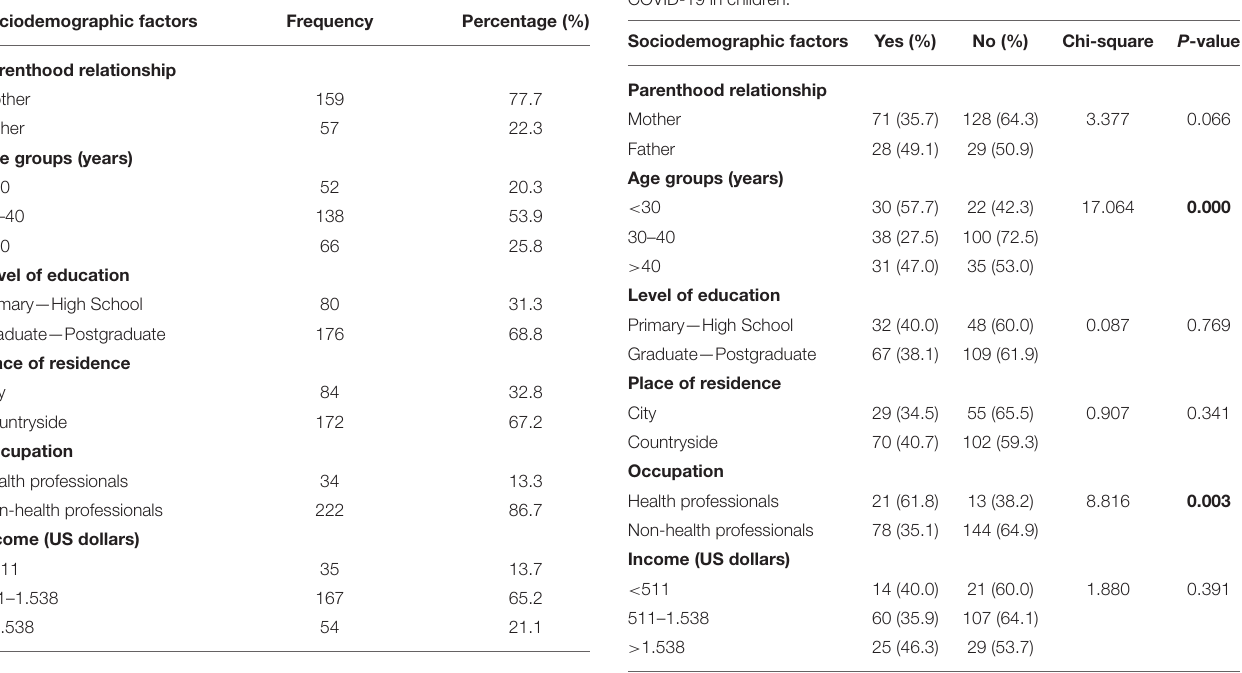
TABLE 1 | Sociodemographic features of the parents.